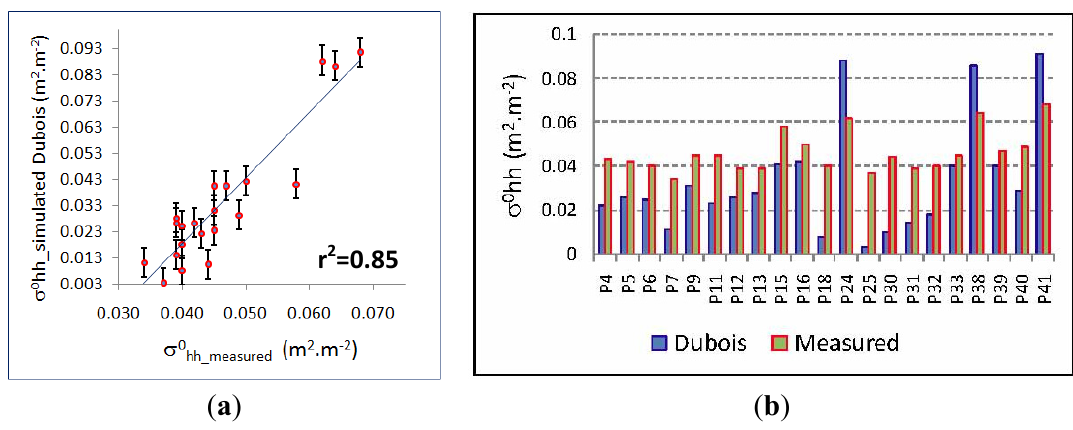
σ vs. measured- 0 σ regression analysis, ( b ) Dubois- 0 Figure 12. ( a ) Dubois- 0 hh hh σ values. (Error bars show the standard error value). vs. measured- 0 hh